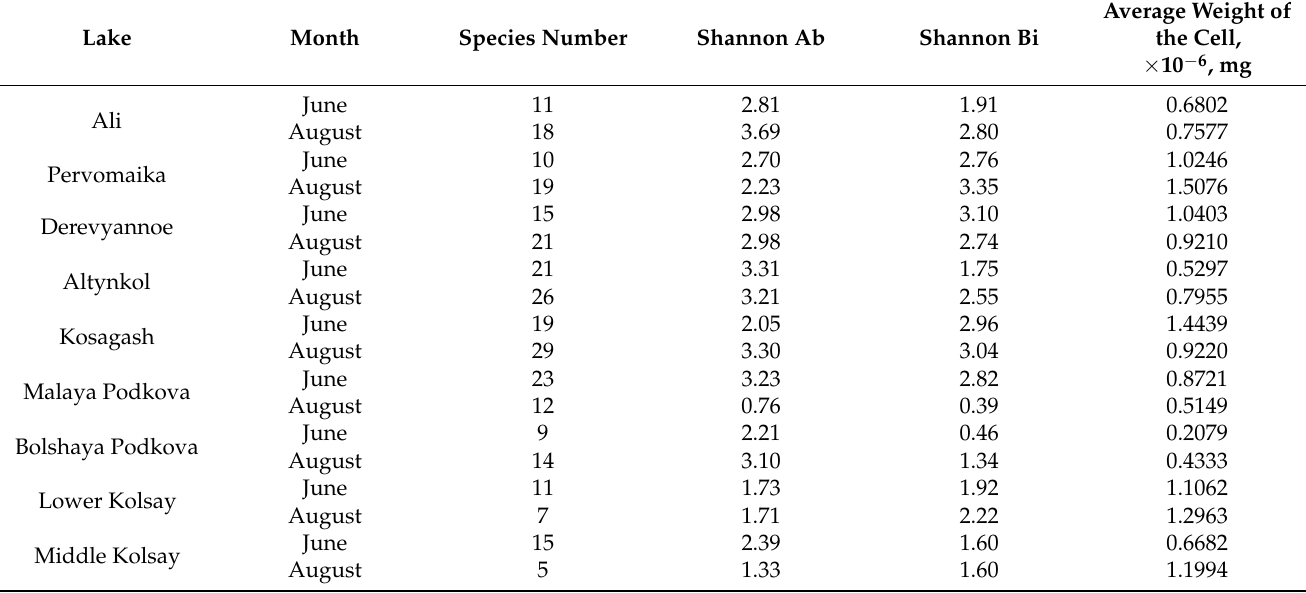
Table 5. Structural variables of phytoplankton in small lakes in South-East Kazakhstan, summer 2019.